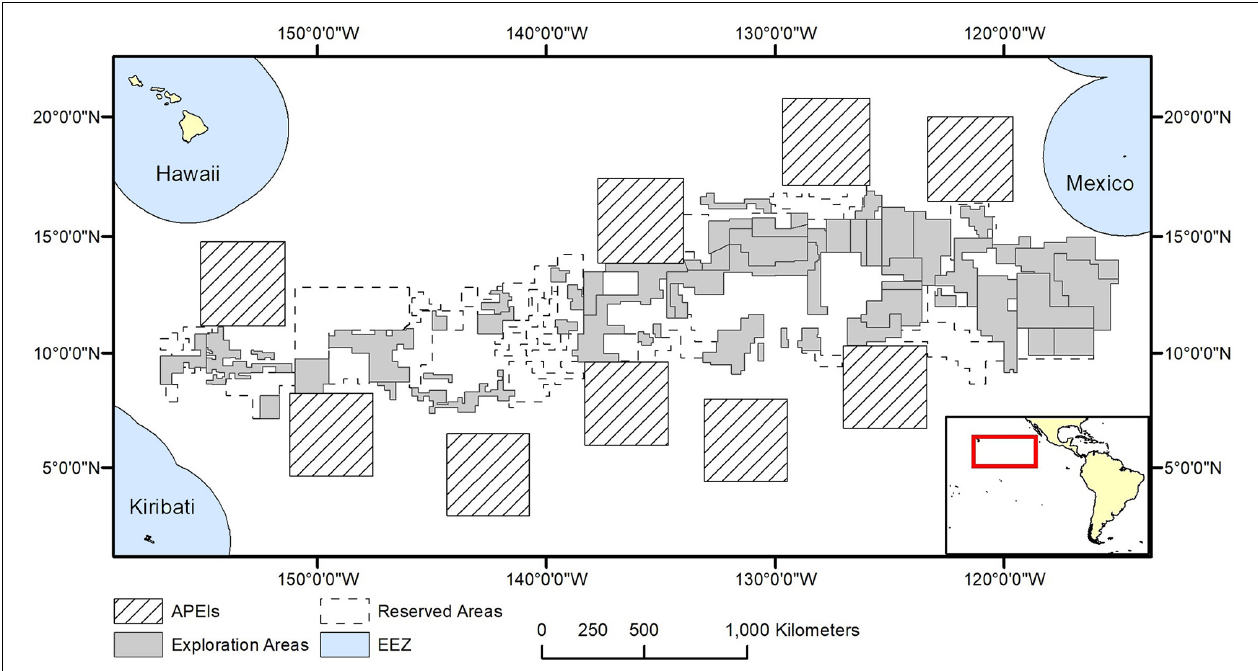
FIGURE 1 | Polymetallic nodule exploration areas in the Clarion-Clipperton Fracture Zone, showing contractor exploration areas, reserved areas and Areas of Particular Environmental Interest